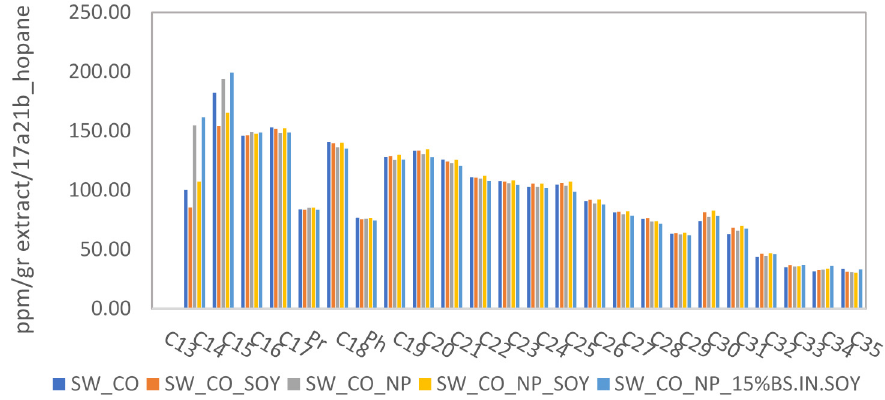
Figure A3. Bioremediation test results. Saturated hydrocarbons concentration after 7 days of bio-